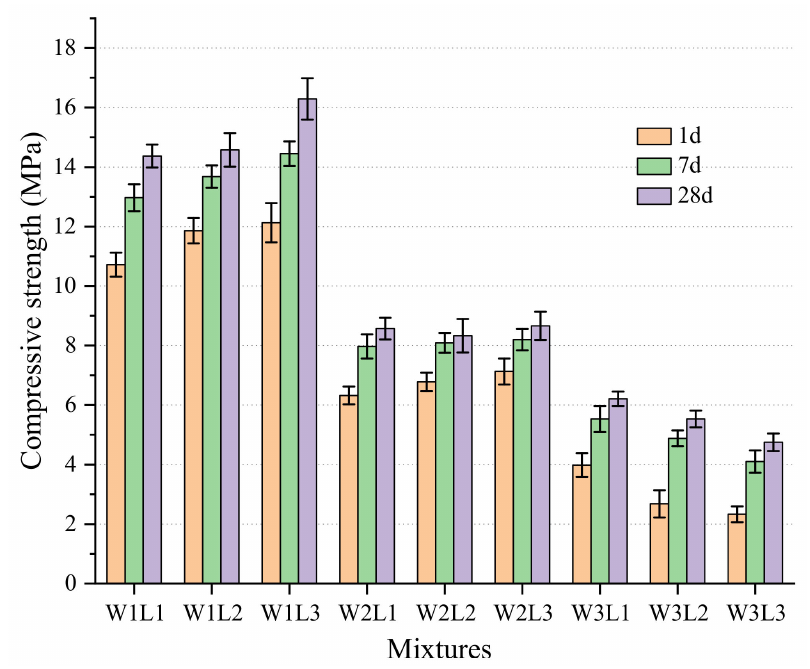
Figure 2. Variation in compressive strength of the high water grouting